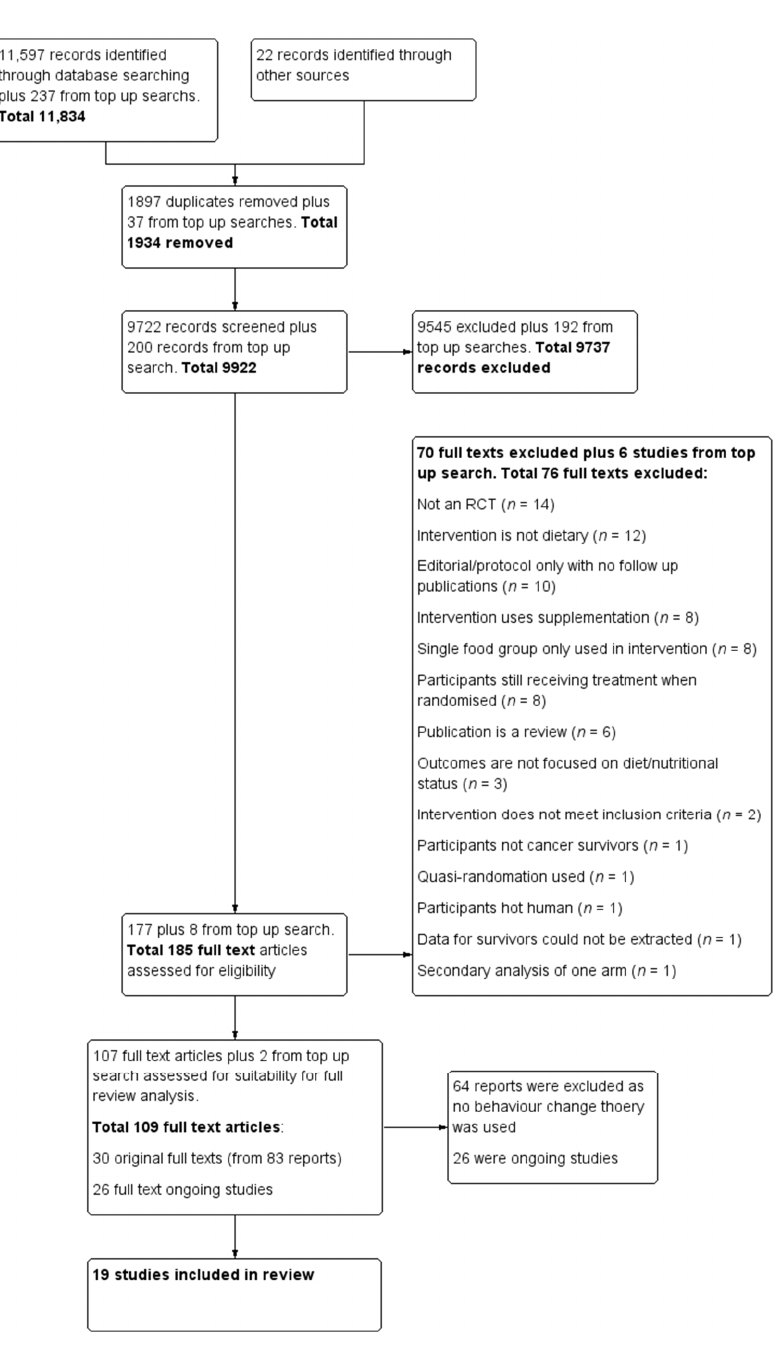
Figure 1. Preferred reporting items for systematic reviews and meta-analysis (PRISMA) flow diagram for the study selection.